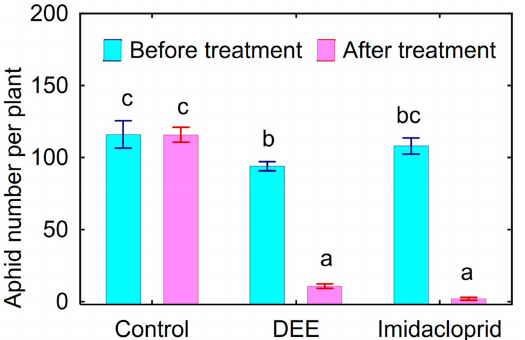
Figure 2. Toxicity of the dried ethanol extract (DEE) of Streptomyces sp. P-56 and imidacloprid against peach aphid in greenhouse experiment with bell pepper cultivar Lastochka in vivo. Vertical bars show standard error. Different letters show significant differences between treatments (least significant difference test, p < 0.05, n = 4).